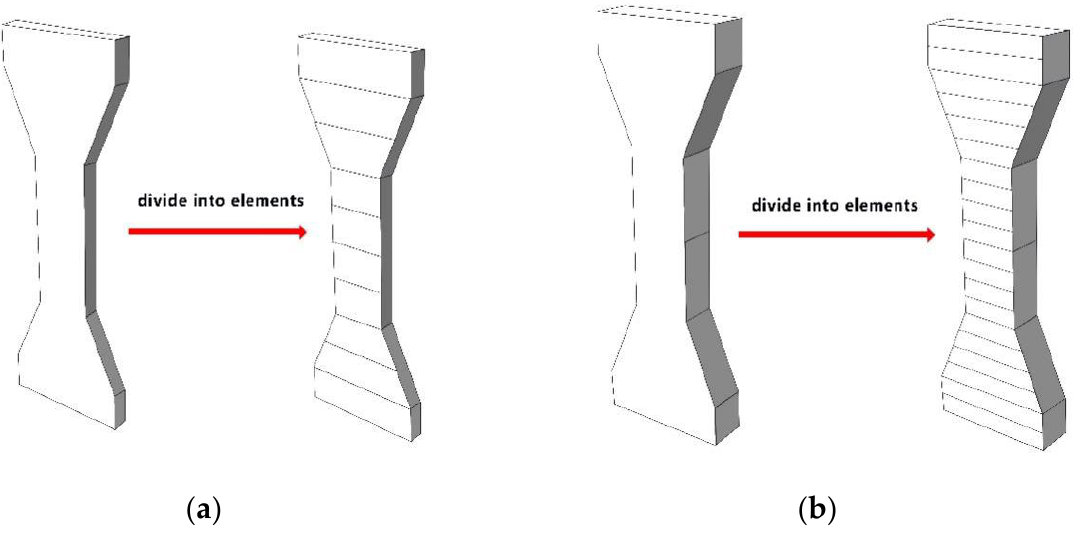
Figure 8. Geometric division of the axial tension model. ( a ) Specimen is printed horizontally; ( b ) Specimen is printed vertically.